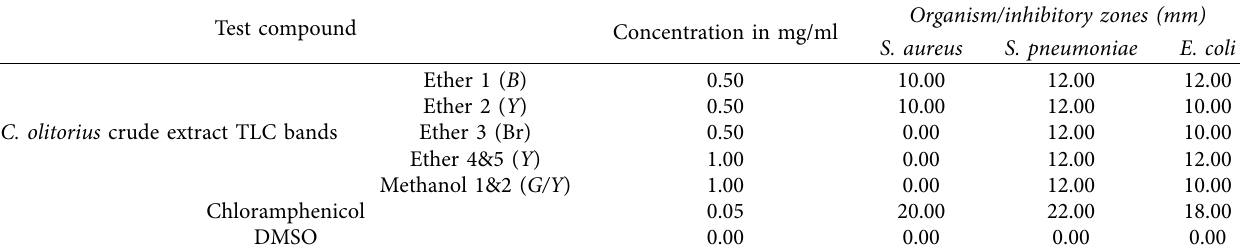
Table 2: Bioactivity of C. olitorius components; mean zones of inhibition (mm).